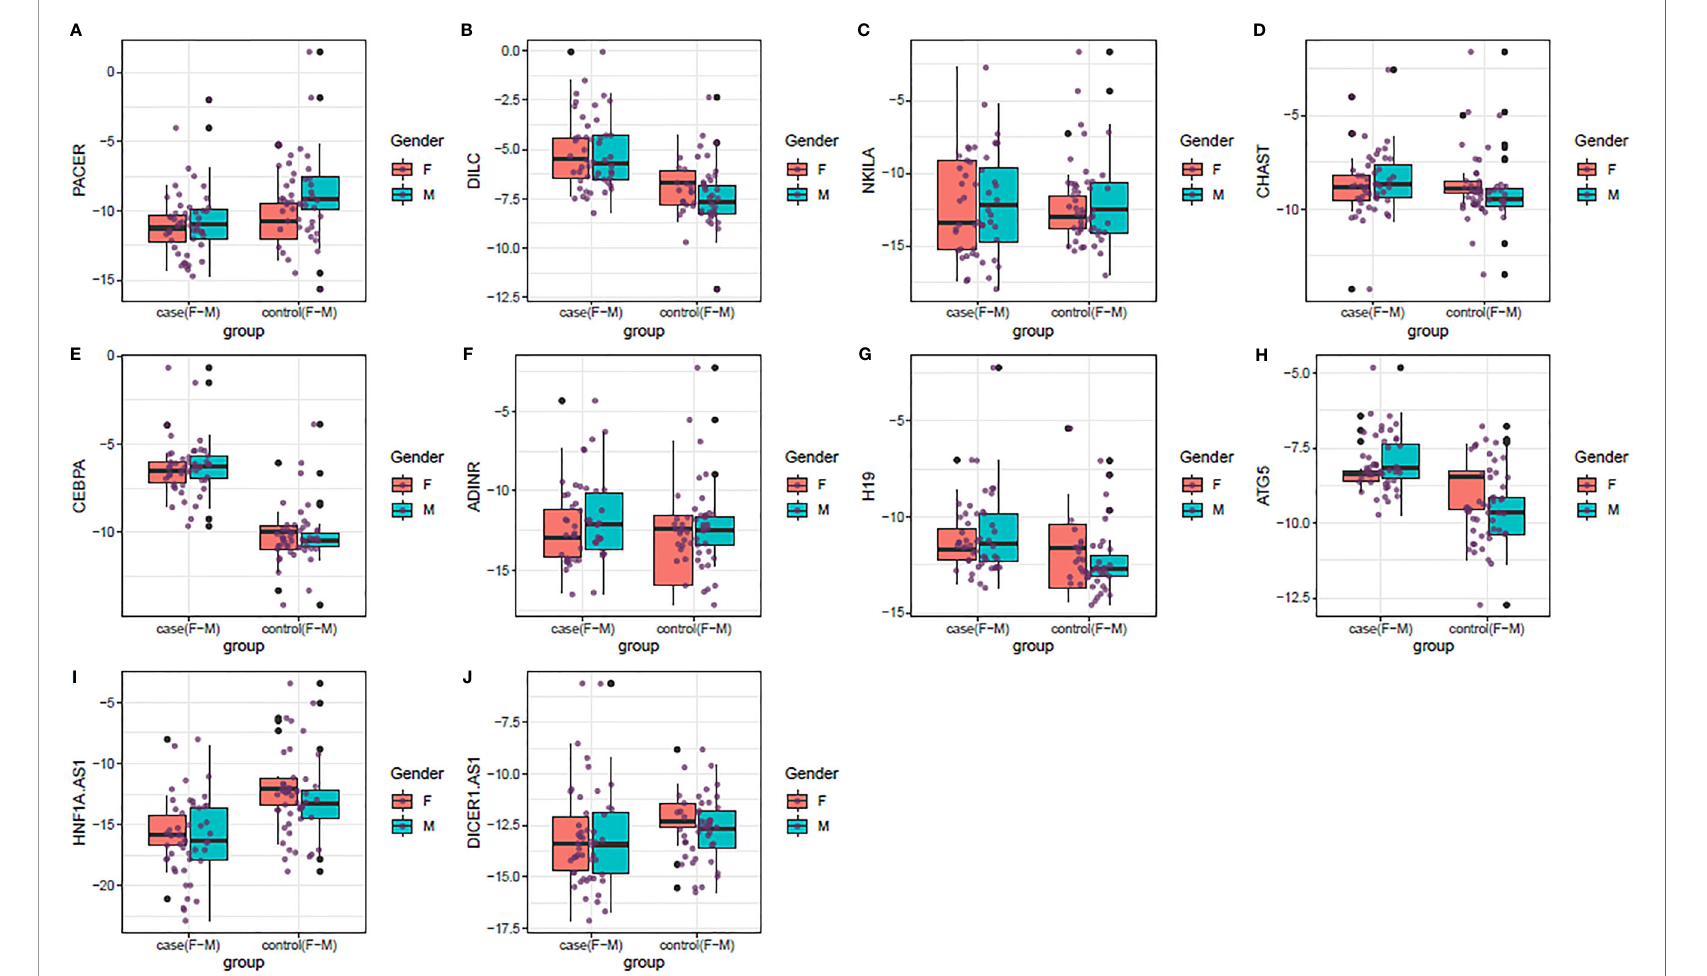
FIGURE 1 | (A – J) Box-and-whisker plots showing the minimum values, the fi rst quartiles, the medians, the third quartiles, and the maximum values of relative expressions of genes in PD cases and controls based on their gender (Red and blue plots show respective values among females and males,